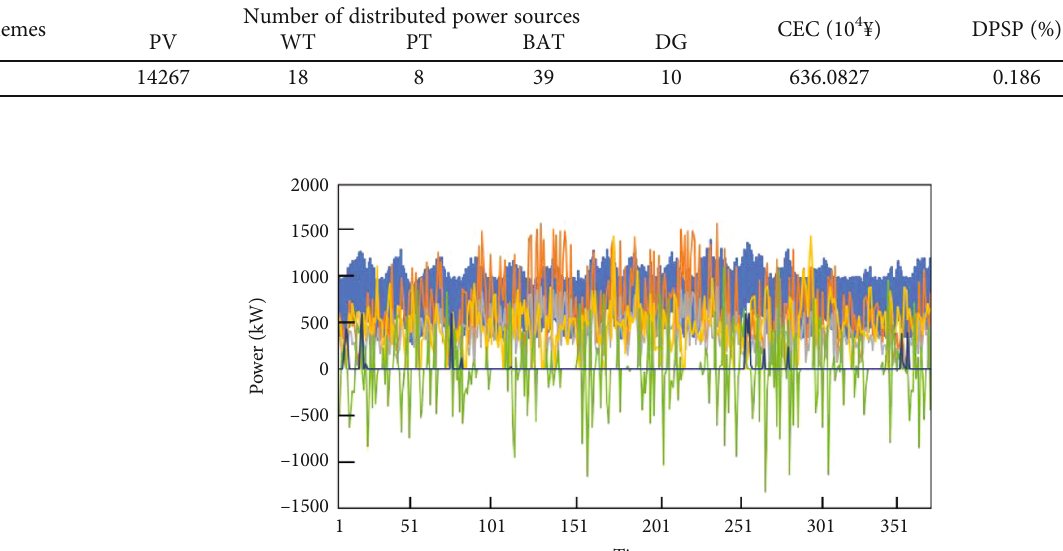
Table 6: Distributed power supply con fi guration results of